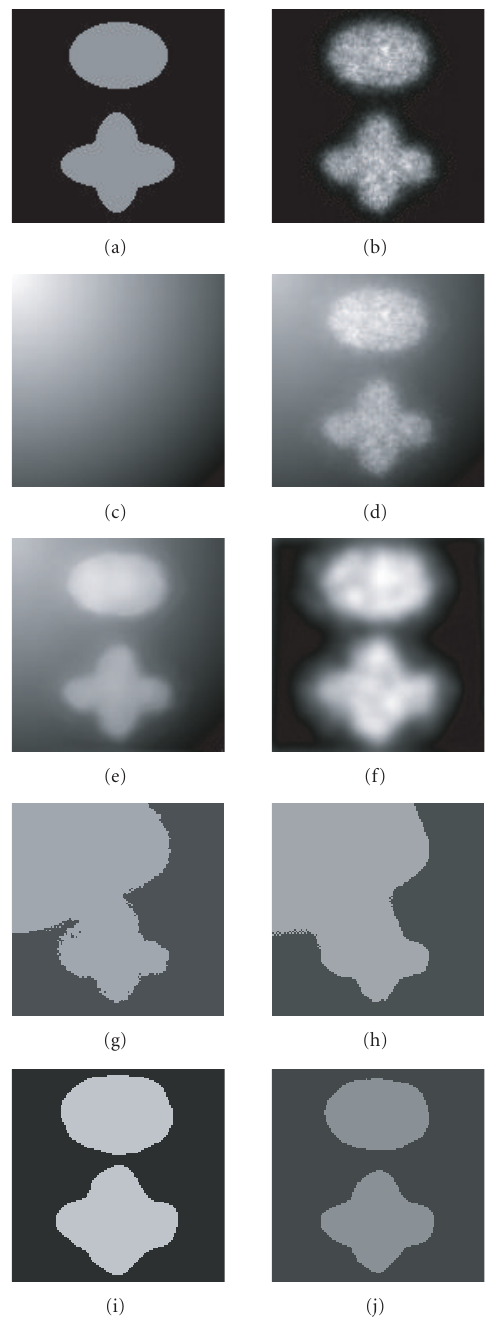
Figure 3: Segmentation results on the first synthetic image: (a) the ground truth image; (b) the synthetic image generated by MOSE; (c) the intensity inhomogeneity model; (d) the synthetic image cor- rupted by the intensity inhomogenetiy; (e) the denoising result with the GNF plus SRAD; (f) the texture feature image; (g) the FCM re- sult on (d); (h) the FCM S result on (d); (i) the FCM result on tex- ture feature image; (j) the 2DFCM